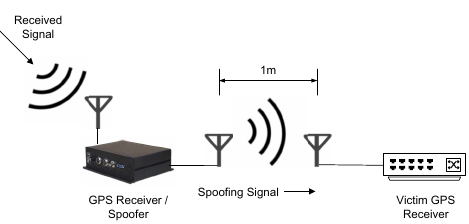
Figure 6. A Spoofing attack via a portable receiver-spoofer